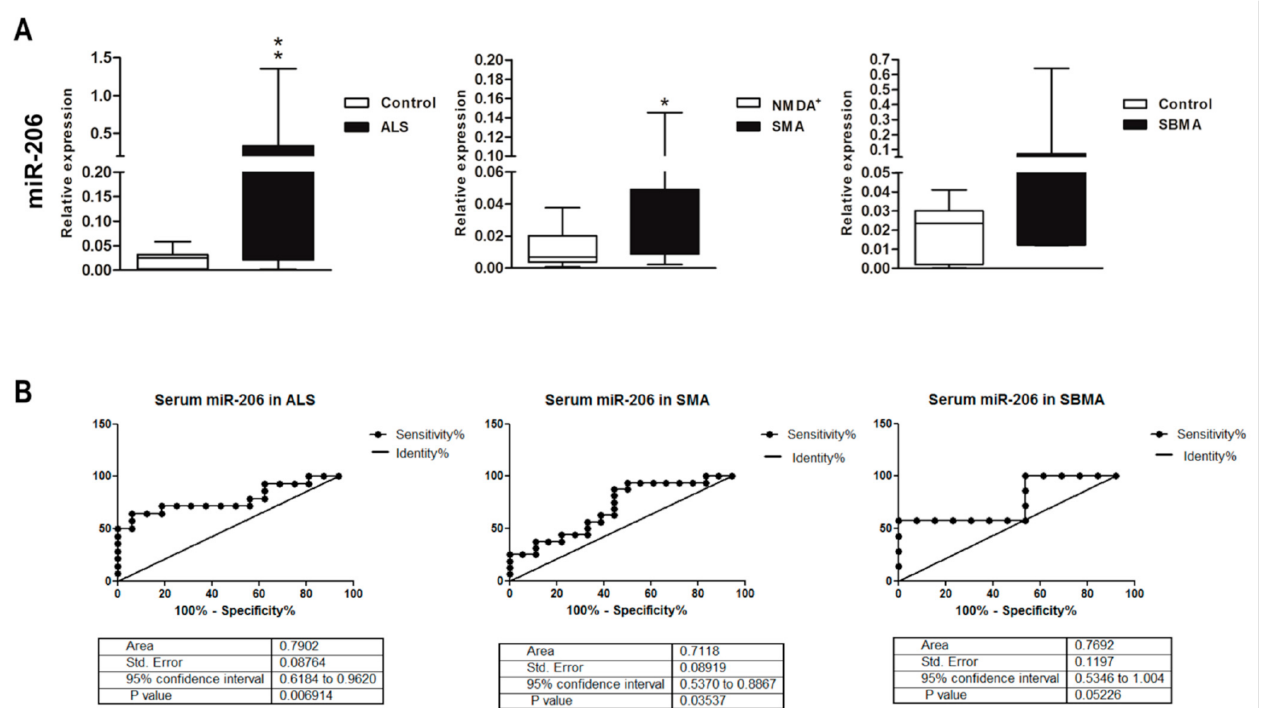
Figure 7. Up-regulation of miR-206 in serum of ALS, SMA, and SBMA patients. ( A ) Quantitative real-time PCR analysis of myomiRs in total RNA extracted from serum of ALS, pediatric SMA, and SBMA patients (black bars), healthy controls (white bars) and patients with anti-NMDA receptor encephalitis (white bars in the SMA graph) as controls for pediatric SMA. Relative expression data are presented as mean ± SEM of 2 − ∆ Ct values normalized against the endogenous control miR-16. * p < 0.05, ** p < 0.01, Mann–Whitney test. ( B ) Receiver operating characteristic (ROC) curves used to assess the sensitivity and specificity of miR-206 in serum as biomarker for ALS, SMA, and